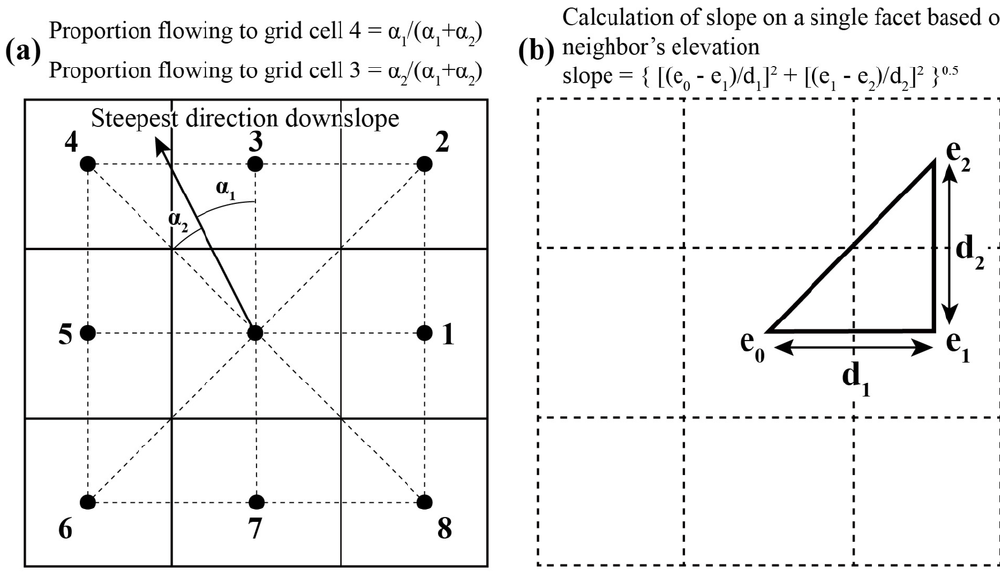
Figure 4: D-Infinity Flow Algorithm. Adapted from Tarboton, (1997), Extracted form Yang et al.,